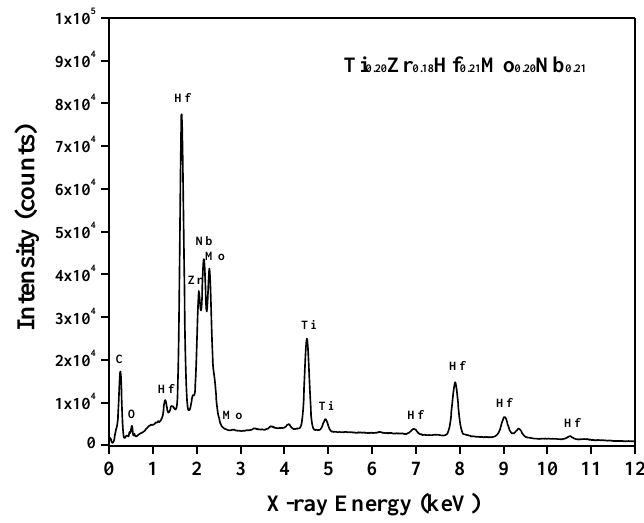
Figure 2. EDS spectrum of TiZrHfMoNb HEA alloy before hydrogenation.